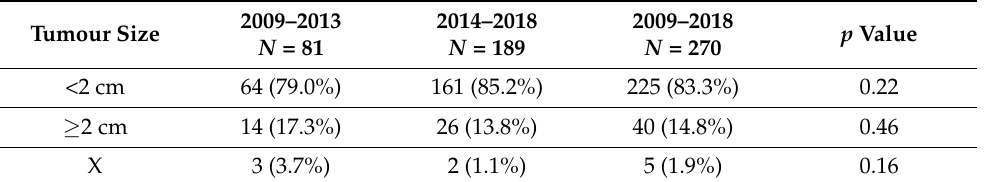
Table 3. Patients subdivision according to the tumour size.